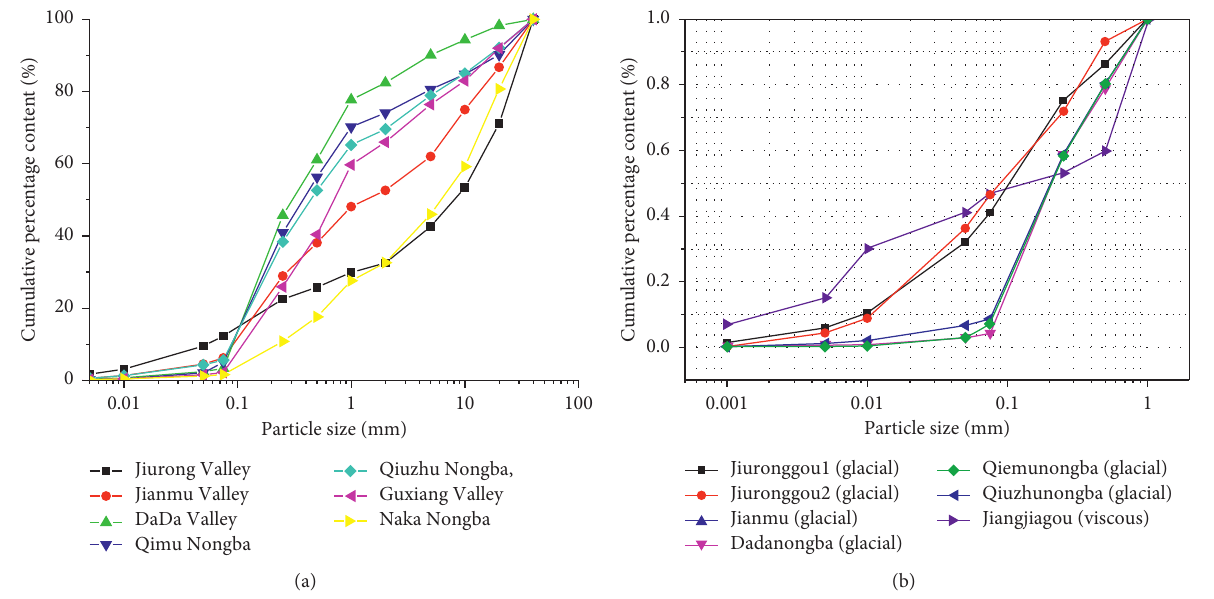
Figure 5: Grading curve of debris flow. (a) Grading curve of glacial debris flow. (b) Comparison of grading curves for glacial debris flow and viscous debris